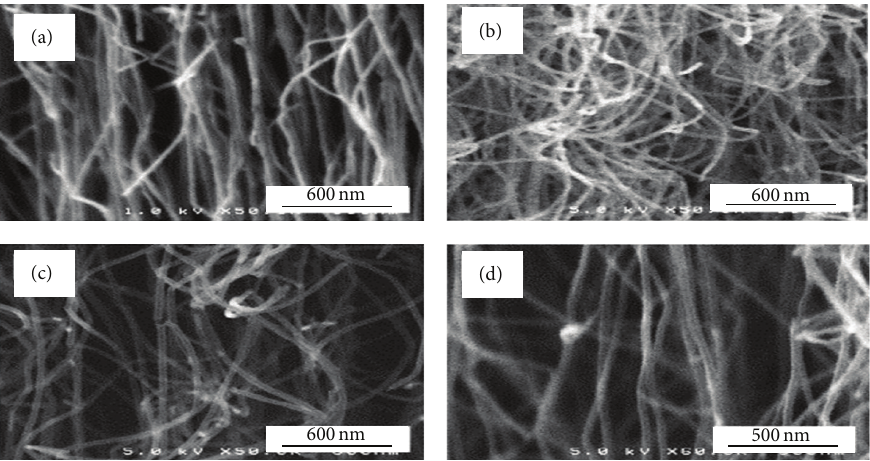
Figure18:HighmagnificationSEMpicturesofverticallyalignedCNTsonsamples((a)–(d))indicatingthedifferentdegreesoftubealignment [108].